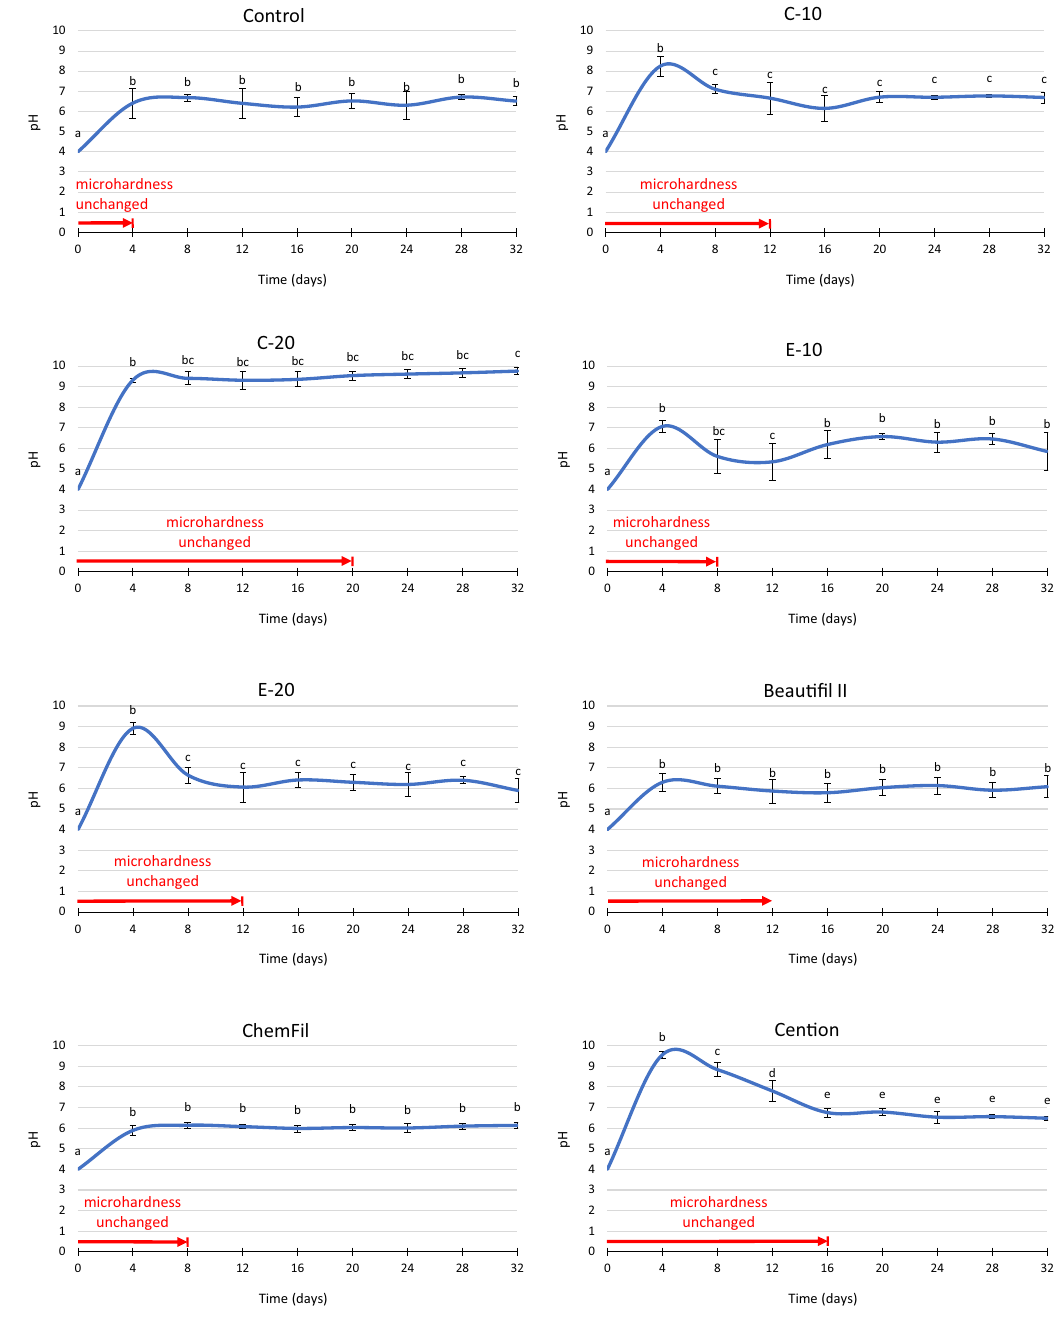
Figure 3. pH changes (mean values ± standard deviations) of the immersion medium and time periods for which enamel microhardness remained unchanged compared to initial values. Same letters denote statistically similar pH values within a